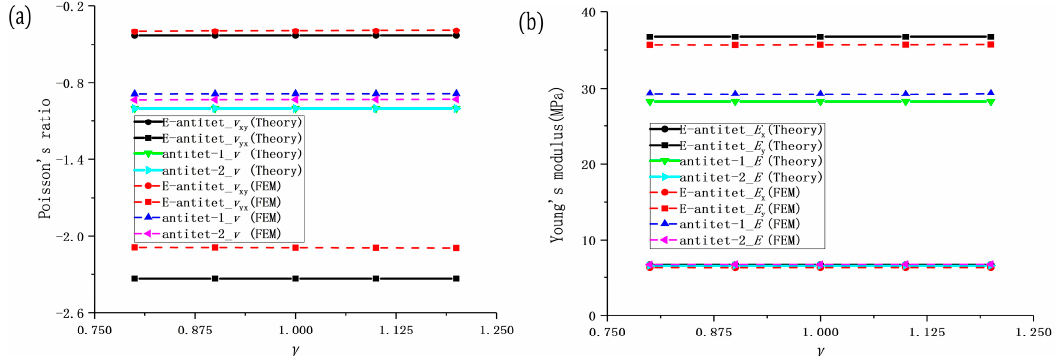
Figure 9. Trends of Poisson’s ratio and Young’s modulus of E-antitet at different 𝛾 : Comparison of the results of analytical and numerical solutions of E-antitet with antitet-1 and antitet-2. ( a ) Poisson’s ratio and ( b )Young’s modulus.